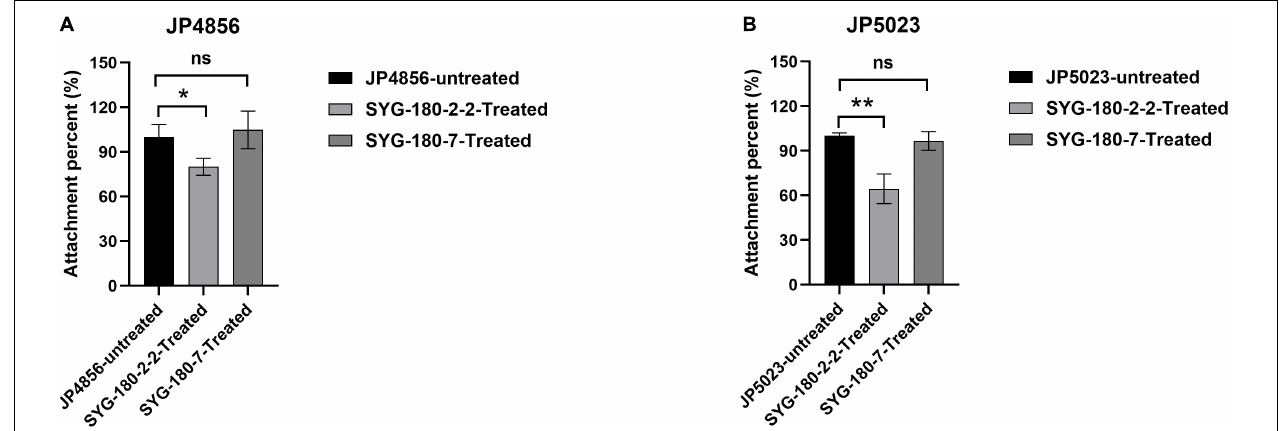
FIGURE 8 | Attachment percent of JP5023 (A) and JP4856 (B) explored by attachment assay (the control was set to 100%). * P < 0.05 and ** P < 0.01.